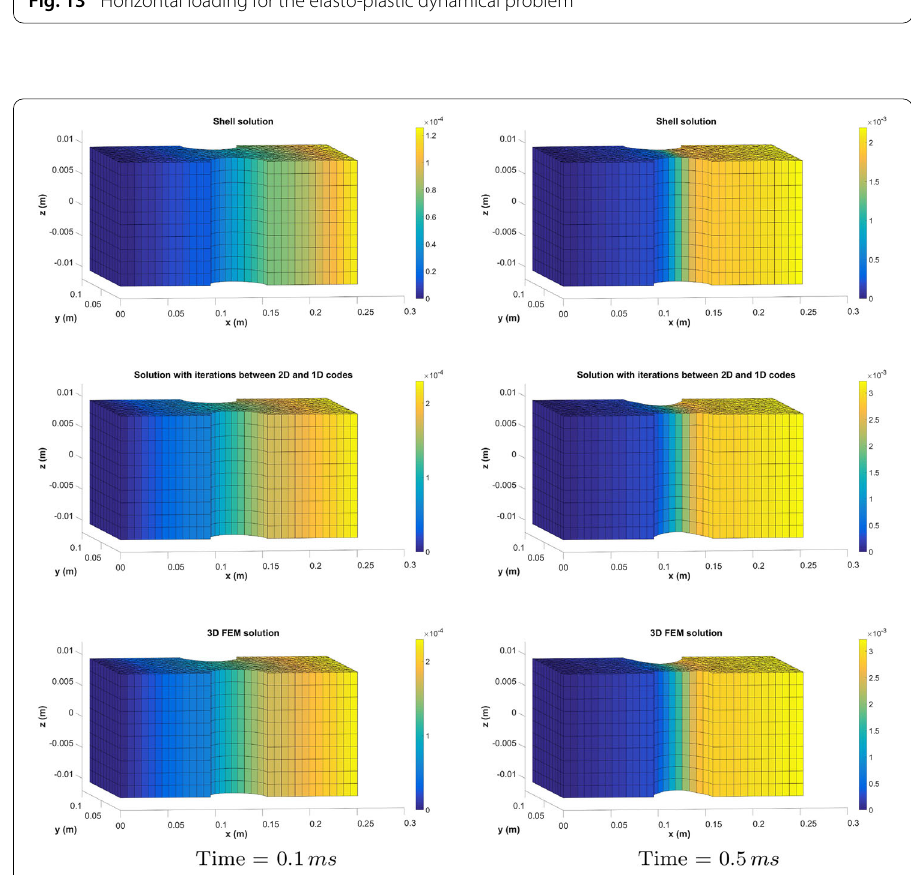
Fig. 14 Displacement field using the three methods for t = 0 . 1 ms and t = 0 . 5 ms